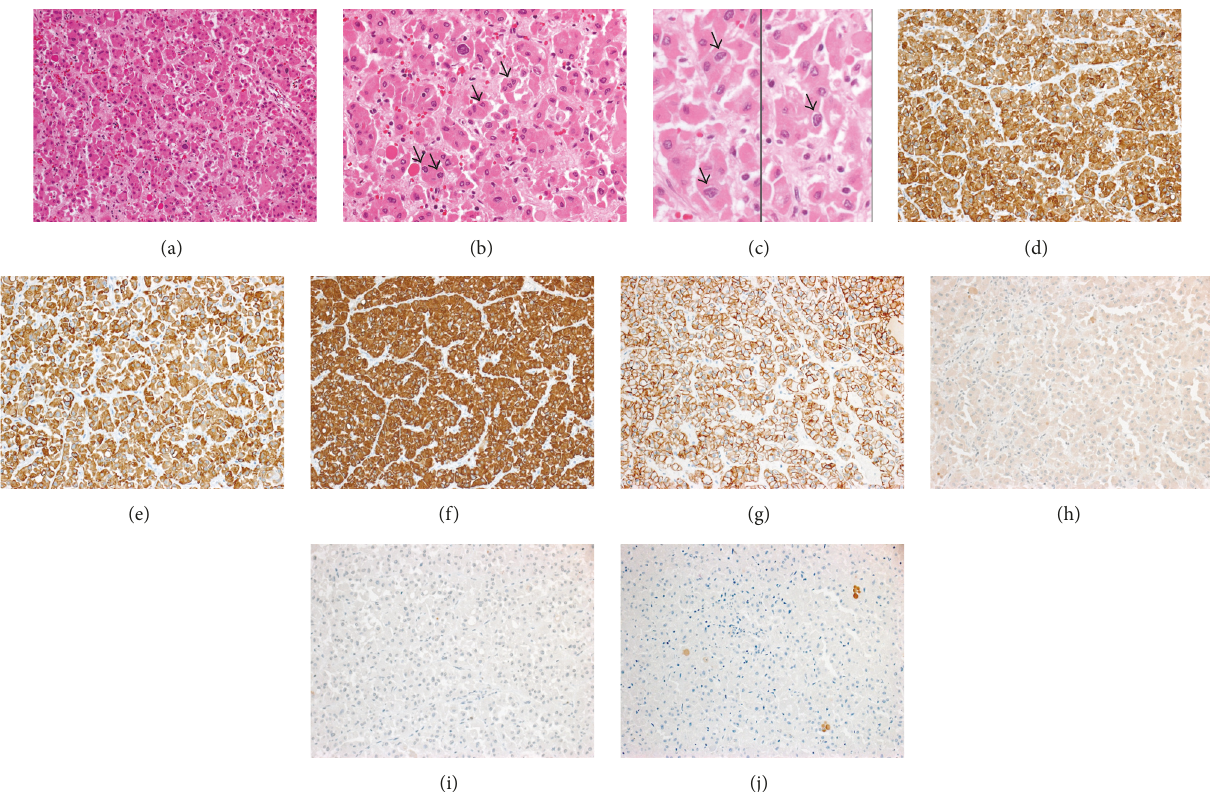
Figure 2: (a) Histopathological examination of the renal allograft tumour showed eosinophilic chromophobe renal cell carcinoma. The tumour consisted of medium to large round and polygonal neoplastic cells arranged in variably sized nests and cords and poorly formed acini [H&E × 200]. (b) Tumour cells exhibited hyperchromatic nuclei, irregular “raisinoid” nuclear membranes (arrows) and voluminous, and dense eosinophilic cytoplasm [H&E × 400]. (c) Tumour cells “raisinoid,” wrinkled nuclear membranes, and perinuclear cytoplasmic clearing (arrows) [H&E × 600]. Immunophenotypically, the tumour cells exhibited positive immune reaction to pancytokeratin (CK) (d), low-molecular weight CK (e), CK7 (diffuse and strong staining, (f)), and E-cadherin (g), while staining for renal cell carcinoma (h), CD10 (i), and CD117 (j) antibodies was negative [(d–j) ×